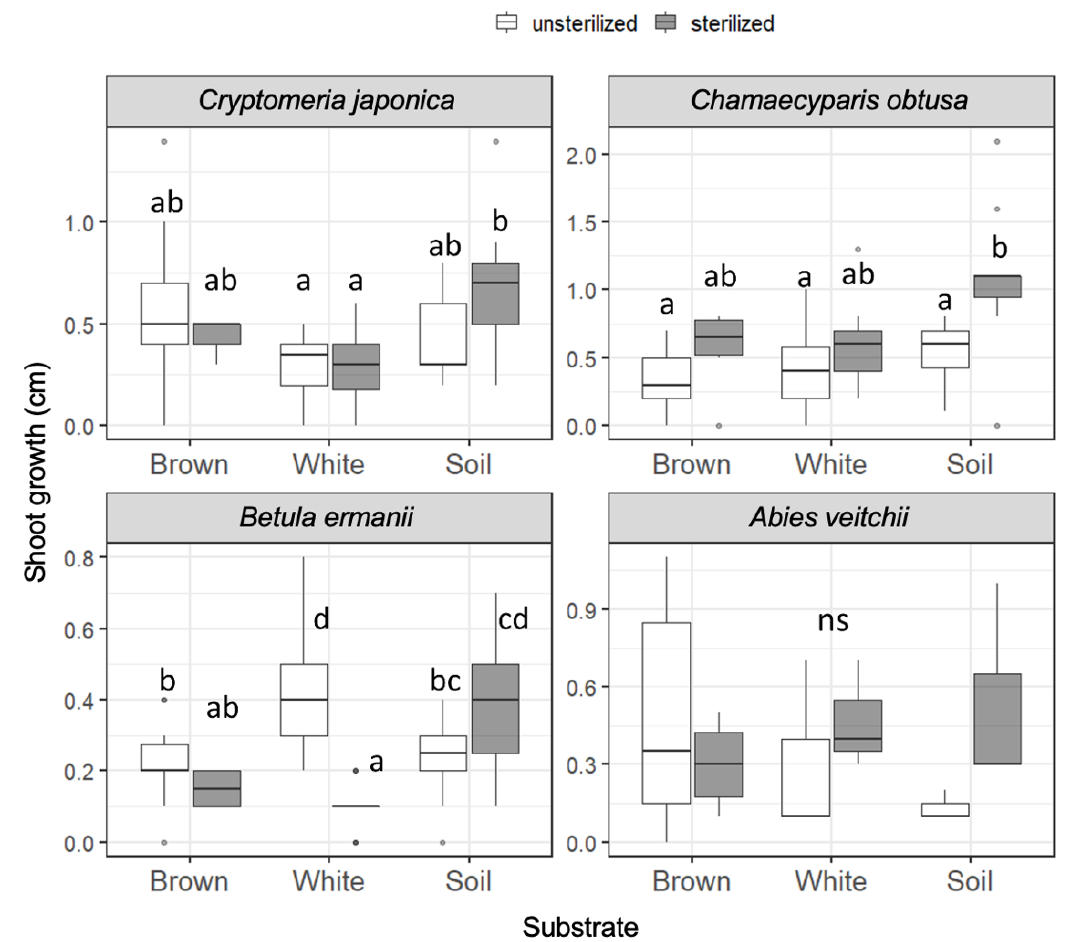
Figure 2. Seedling shoot growth of the four tree species during 121 days on unsterilized and sterilized substrates (brown rot wood, white rot wood, and soil). Box plots display median, 95% confidence interval, and the minimum and maximum values and points outside the box represent outliers. Different letters indicate significant differences among the six substrates ( p < 0.05, Permuted Brunner–Munzel test with Holm adjustment of probability values). ns, not significant. n = 15 except for A. veitchii ( n = 8).